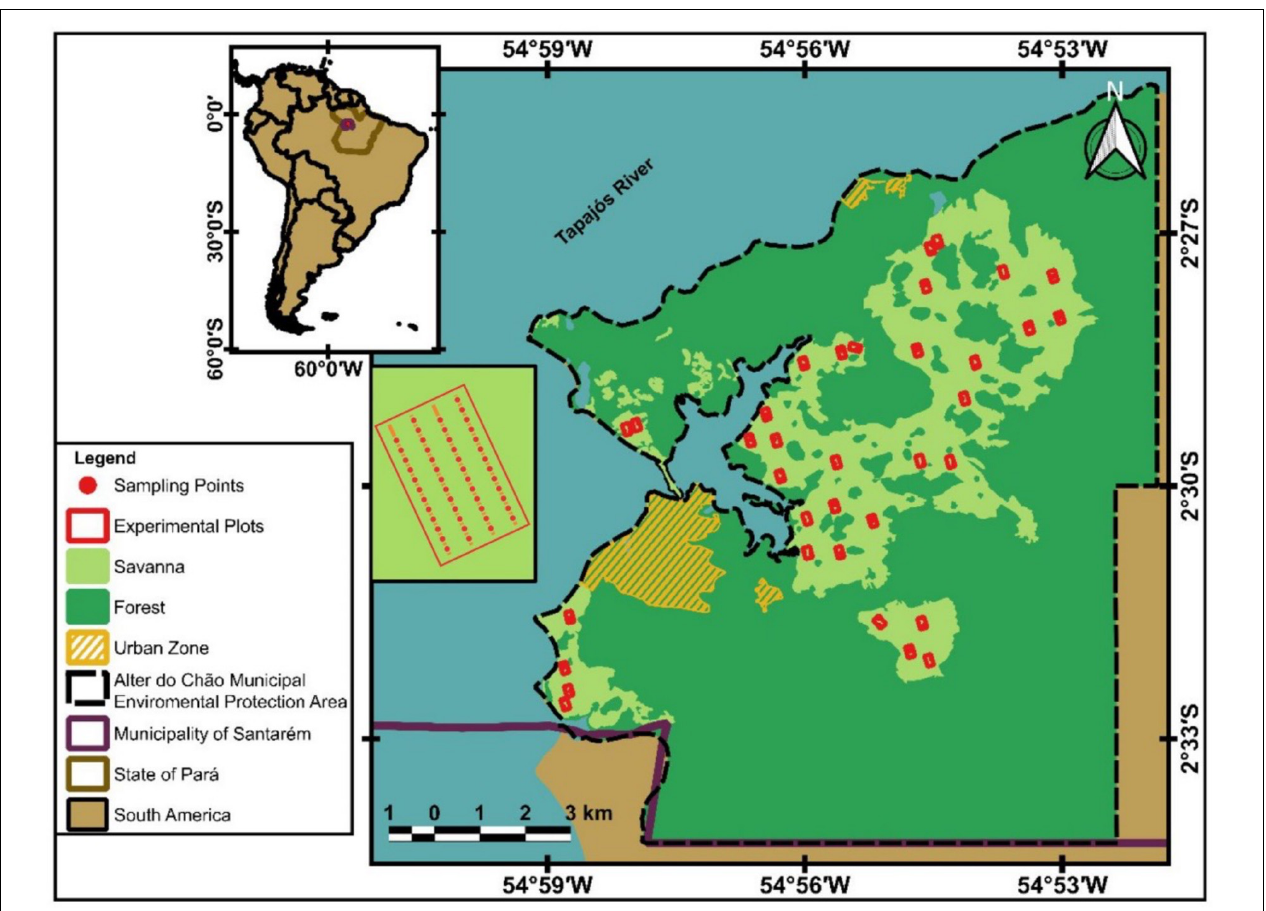
FIGURE 1 | Sampling areas used to study Necromys lasiurus near Alter do Chão, Santarém,